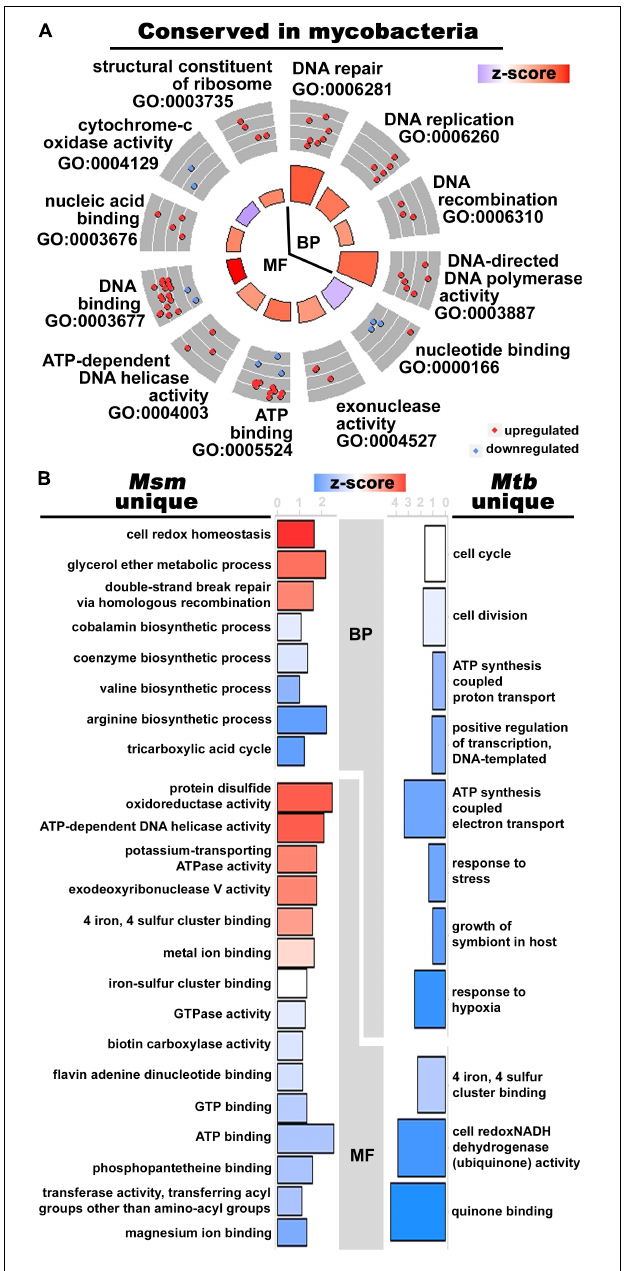
FIGURE 2 | The alignment and discordance of DE orthologous genes in Zn 2 + -limited Msm and Mtb . (A) Circle plot showing enriched GO terms in the orthologous genes with shared differential expression patterns in response to Zn 2 + limitation in mycobacteria. The enrichment was conducted using the locus tags from Msm . See Figure 1C for circle plot explanation. (B) Inflected vertical bar graphs of enriched GO terms in the orthologous mycobacterial genes that were uniquely regulated in Zn 2 + -limited Msm (left) and Mtb (right). The enrichments were conducted using the locus tags of the respective mycobacterial species (i.e., MSMEG tags for unique DE genes in Msm and Rv tags for unique DE genes in Mtb ). The bars are colored by z-score as explained for the circle plot in Figure 1C . The axis of each bar graph is the -log 10 ( p -Value) of the enriched term. Due to the restriction of only considering orthologous genes, significantly enriched GO terms were defined with p -Value < 0.1 for all analyses in this